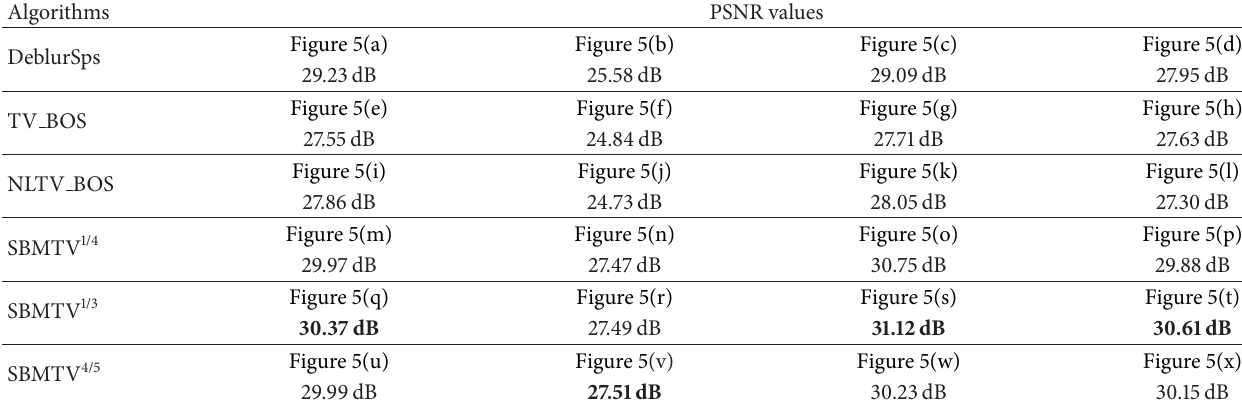
Table 5: PSNRs of images in Figure